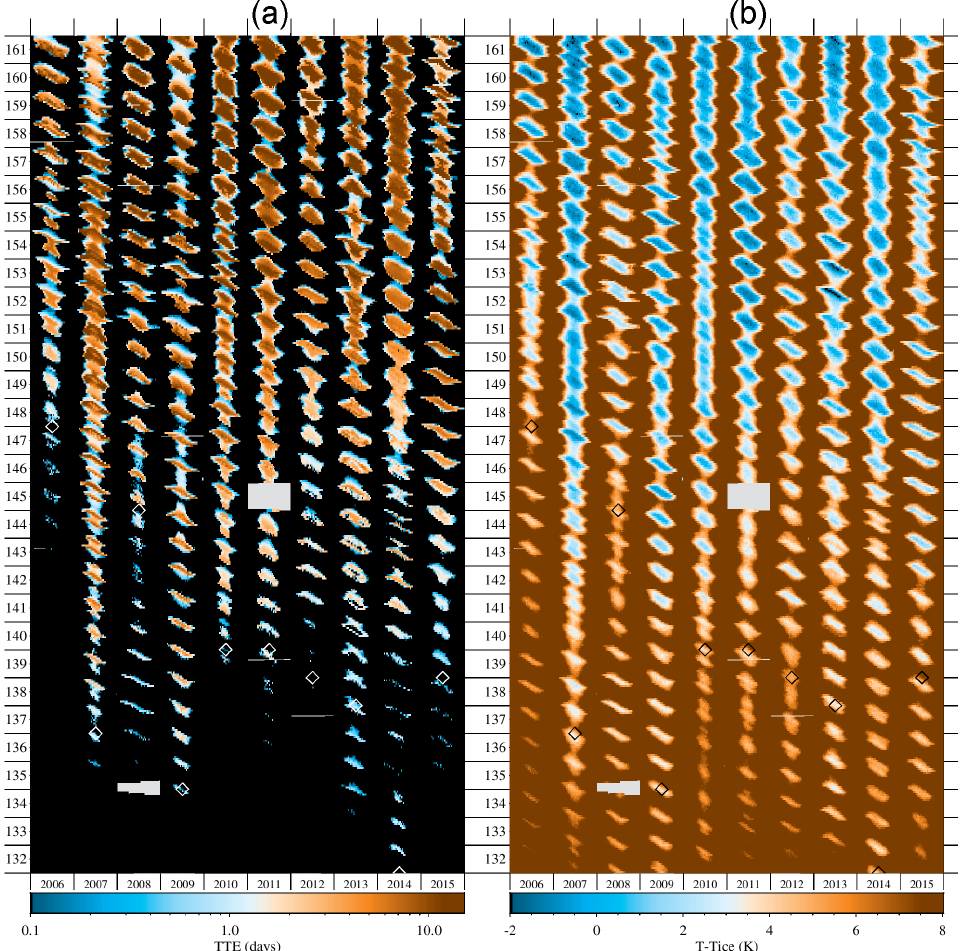
Figure 14. Thirty-day time series of Antarctic raster plots at 32hPa for 2006–2015. Day number is shown on the vertical axis. (a) TTE (days). (b) T − T ICE